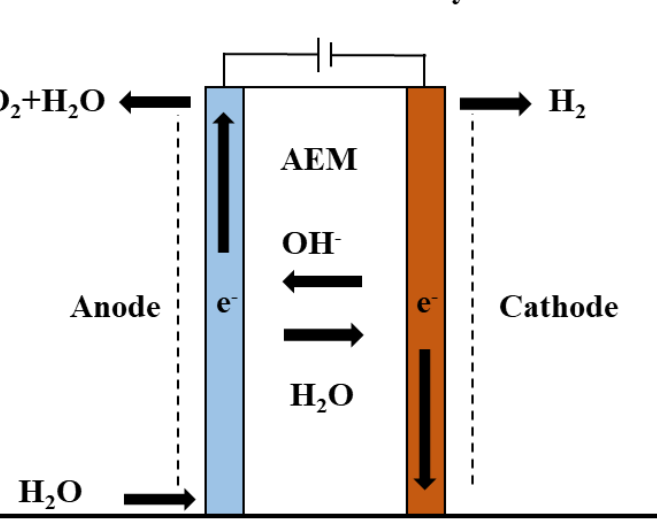
Figure 3. AEM electrolyzer configuration with AEM transporting the OH − to the anode.